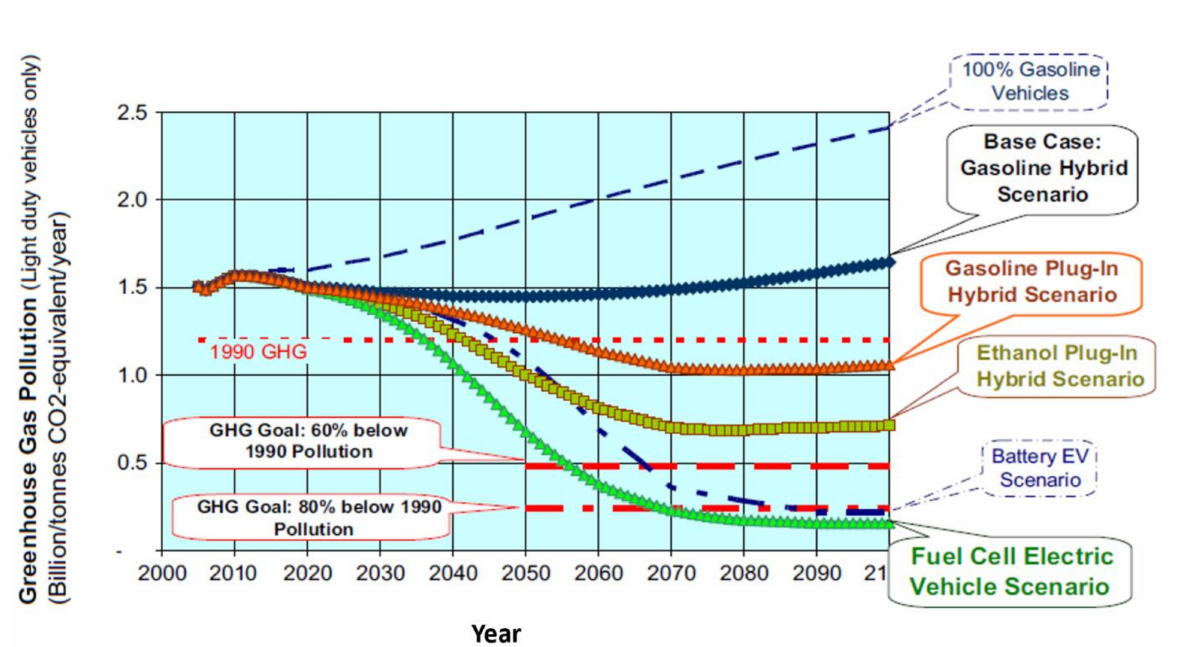
Figure 2. Projected greenhouse gases for different alternative vehicle scenarios